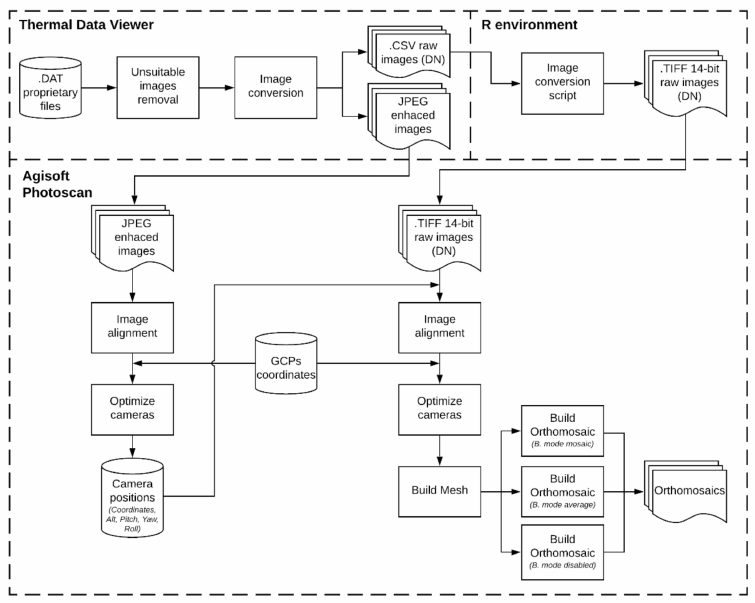
Figure 2. Overall flowchart for orthomosaics